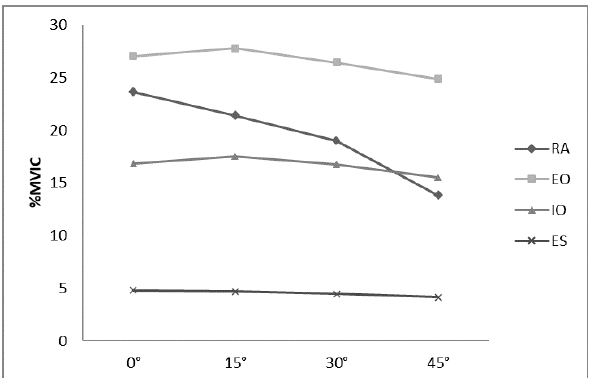
Fig. 1. Muscle activity according to hip abduction. RA, rectus abdominis; EO, external oblique; IO, in-ternal oblique; ES, erector